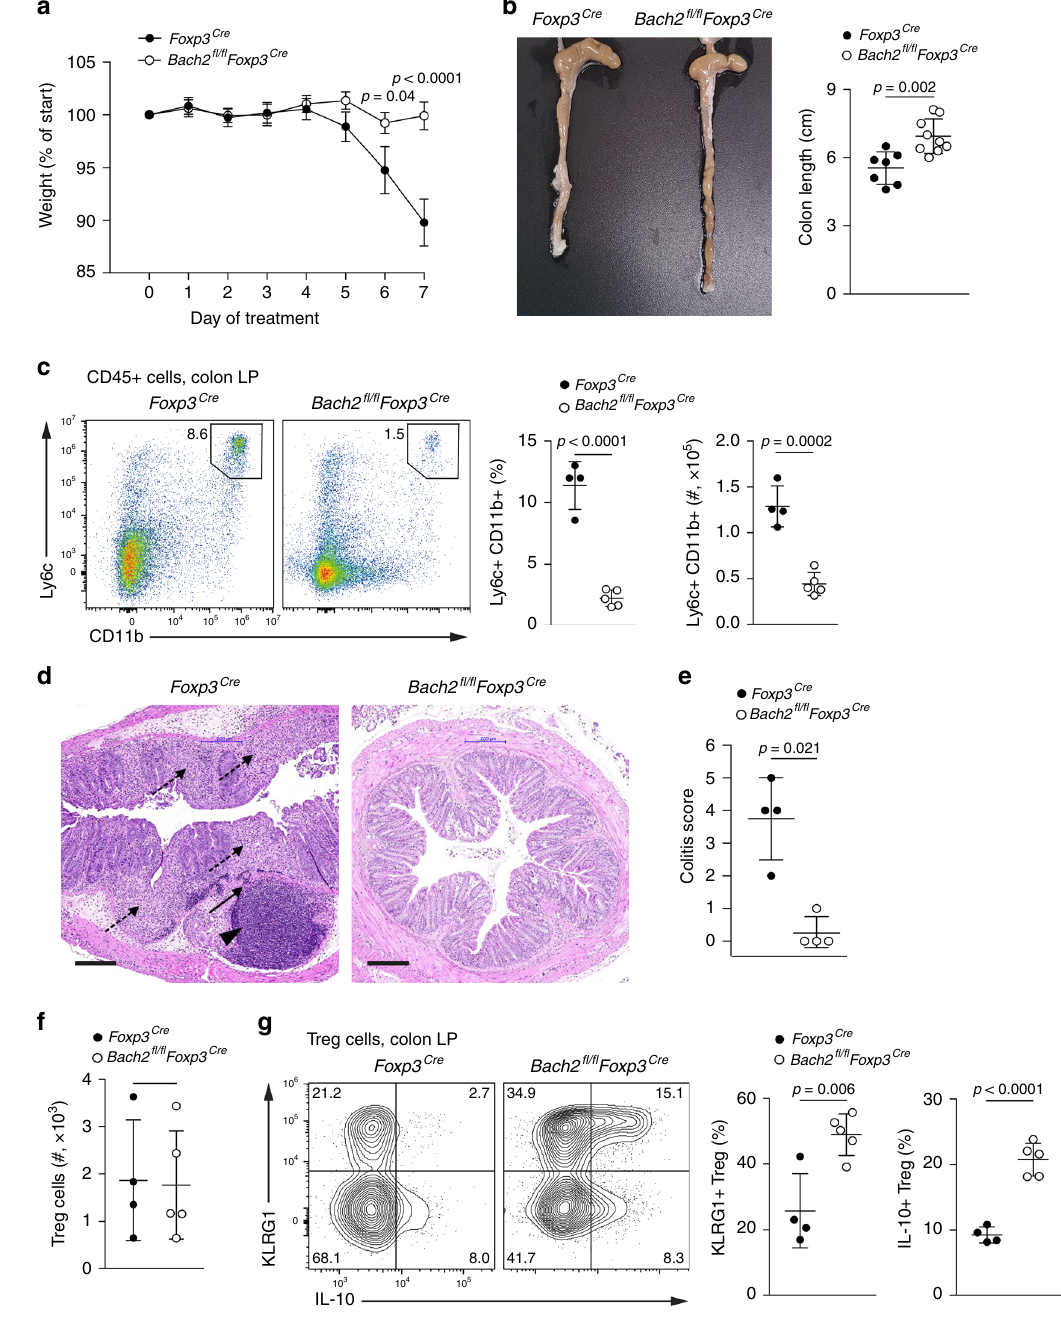
Fig. 3 Bach2 restrains Treg cell suppressive function in colitis. Bach2 fl / fl Foxp3 Cre and Foxp3 Cre control mice were administered 1.5% (w/v) dextran sodium sulfate (DSS) in drinking water for 5 days and regular drinking water for another two days. a Mouse weight over time normalized to starting weight. b Representative colons from DSS-treated Foxp3 Cre and Bach2 fl / fl Foxp3 Cre mice (left) and quanti fi cation of colon length (right). c Flow cytometry plots quantifying monocytes in the colonic lamina propria. d Histological staining of the distal colon of DSS-treated mice. Arrowhead indicates submucosal in fl ammatory in fi ltrate, solid arrow, transmural in fl ammatory in fi ltrate, dashed arrow, mucosal in fl ammatory in fi ltrate and erosion of the crypt-villus architecture. Scale bar = 200 μ m. e Quanti fi cation of disease scores between genotypes. f Frequencies of Treg cells in the colonic lamina propria of DSS- treated Foxp3 Cre and Bach2 fl / fl Foxp3 Cre mice. g Flow cytometry plots showing IL-10 and KLRG1 expression by Treg cells from the lamina propria (left), and quanti fi cation of expression (right). Flow cytometry plots are representative, data are pooled from ( a and b ) or representative of ( c – g ) two independent experiments with seven control and nine conditional knockout mice. Signi fi cance tested using two-way ANOVA with Š idák correction for multiple comparisons ( a ). Otherwise, statistical signi fi cance was tested using the unpaired Student ’ s t- test. Error bars denote mean ± S.D.; ns – not signi fi cant. Source data are provided as a Source Data fi